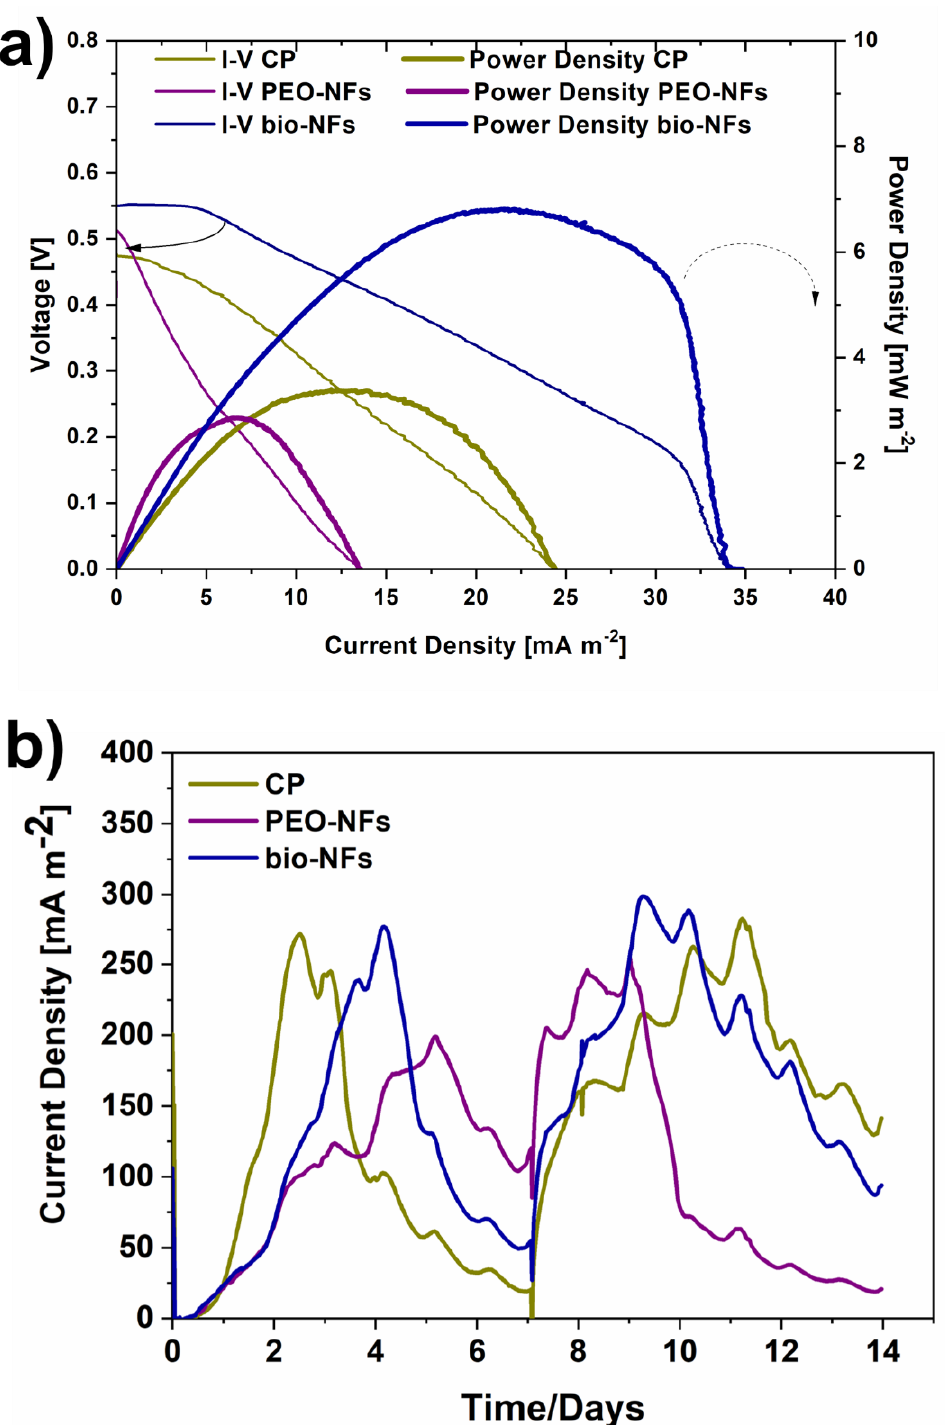
Figure 4. ( a ) Polarization curves obtained by LSV characterization. Potential vs. current density curves (left axis, dash lines) and power density vs. current density (right axis, straight lines) curves of SCMFCs with bio-NFs nanofibers, PEO-NFs and bare carbon-based material CP as reference materials ( b ) Comparison of current density trend of SCMFCs with bio-NFs nanofibers, PEO-NFs and bare carbon-based material CP.